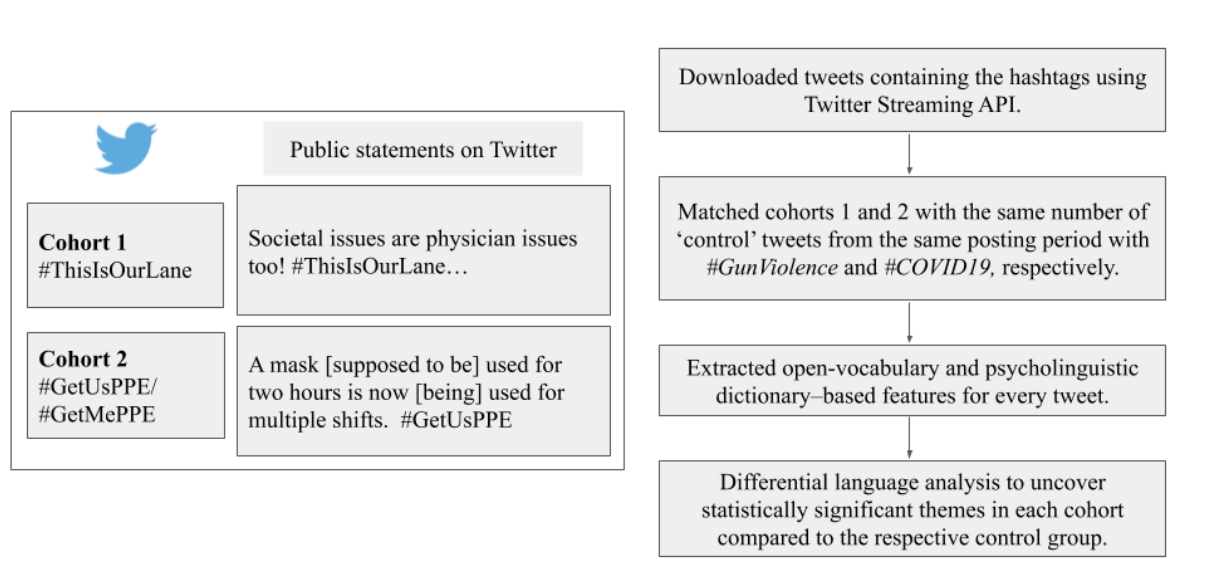
Figure 1. Study flowchart. API: application programming